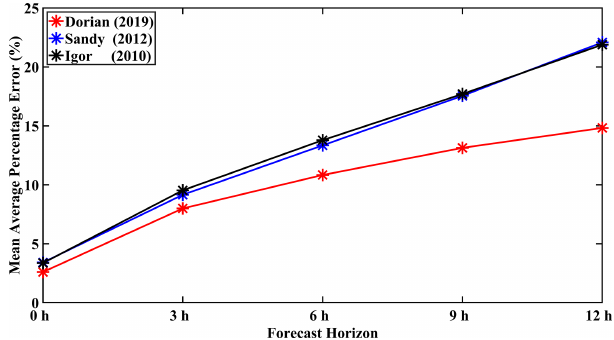
Figure 11. Mean average percentage error (%) for Hurricanes Do- rian (red), Sandy (blue), and Igor (black).